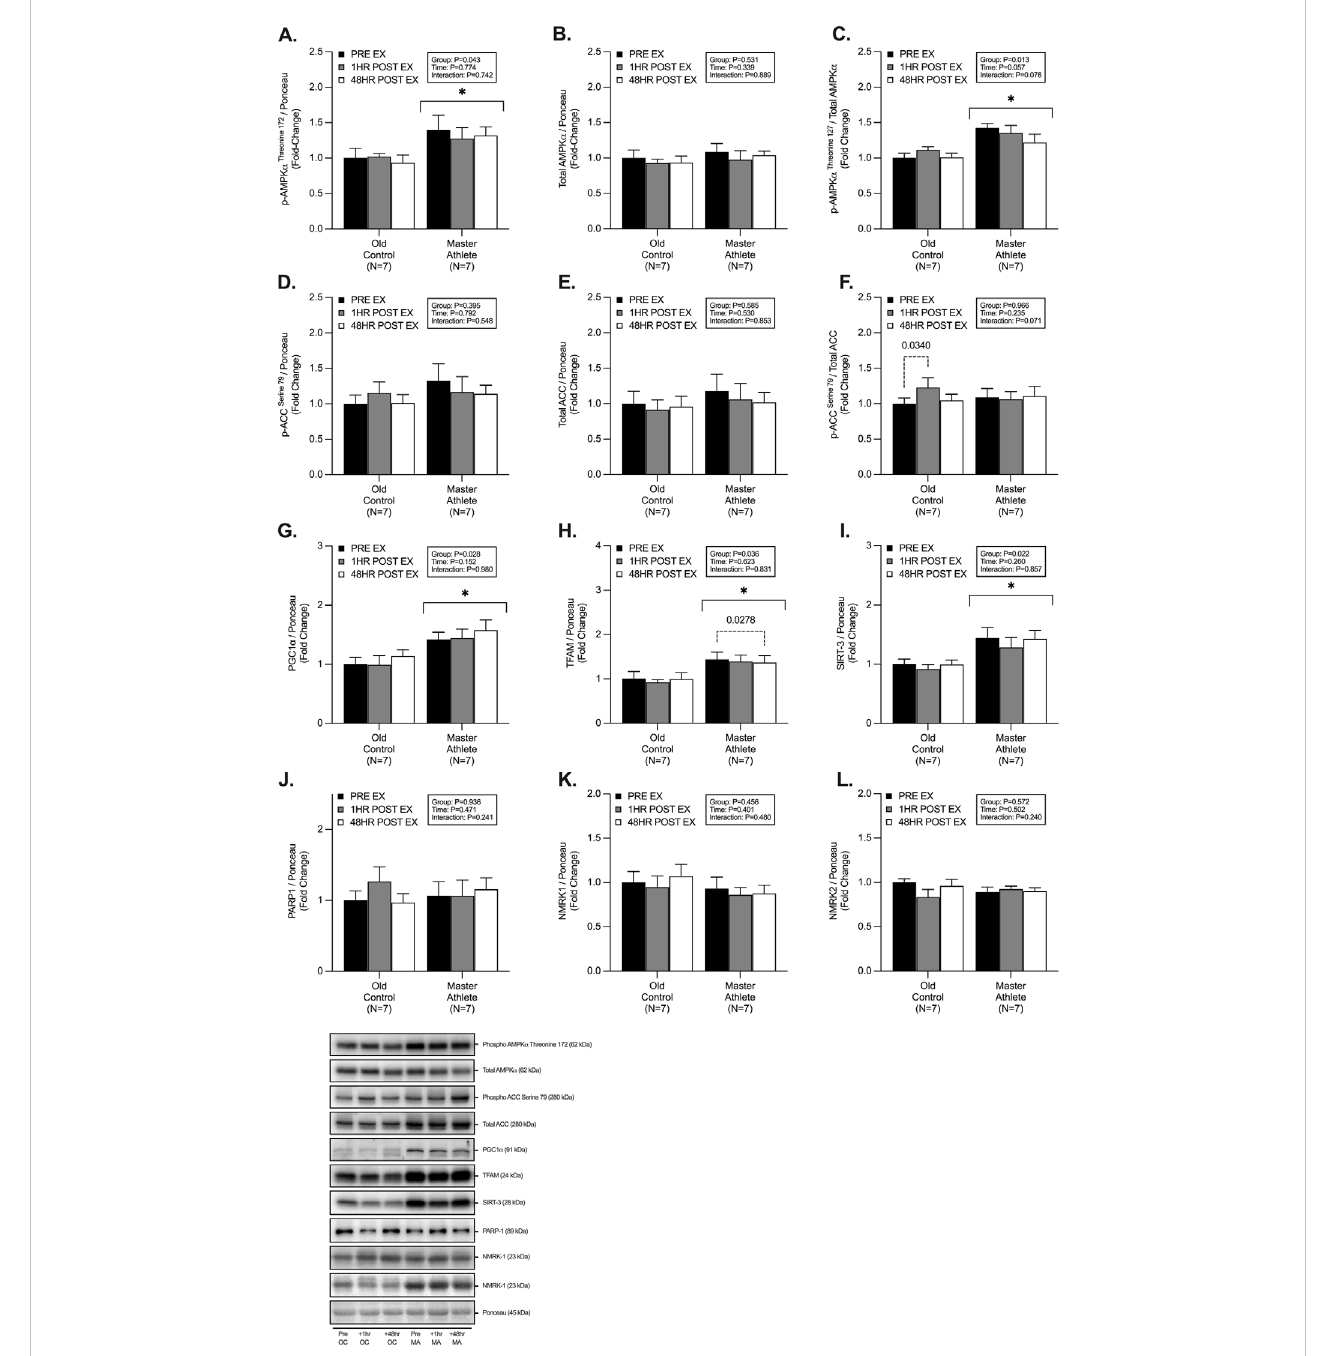
FIGURE 3 Master athletes display greater abundance of proteins involved in mitochondrial biosynthesis compared with old controls. Intracellular mitochondrial signalling of phosphorylated AMPK α Threonine172 (A) total AMPK α (B) phosphorylated:total AMPK α (C) , phosphorylated ACC Serine79 (D) , total ACC (E) , phosphorylated:total ACC (F) , PGC1 α (G) , TFAM (H) , SIRT-3 (I) , PARP-1 (J) , NMRK1 (K) , and NMRK2 (L) at rest (black), 1 h post-resistance exercise (grey), and 48 h post-resistance exercise (white) in older untrained controls (n = 7) and master athletes (n = 7). all proteins are expressed relative to the total protein stain (ponceau s) and, where relevant, expressed at phosphorylated:total as a proxy for the respective activation status of the target protein. Signi fi cance was setat p < .05.Thesymbol “ p ” withsolidblackbarsindicatessigni fi cantlydifferentfromolderuntrainedcontrol( p < .05).The p -valuewithdottedlinesindicates signi fi cantly different from pre-exercise rest ( p < .05). Values are presented as fold-change relative to pre-exercise old